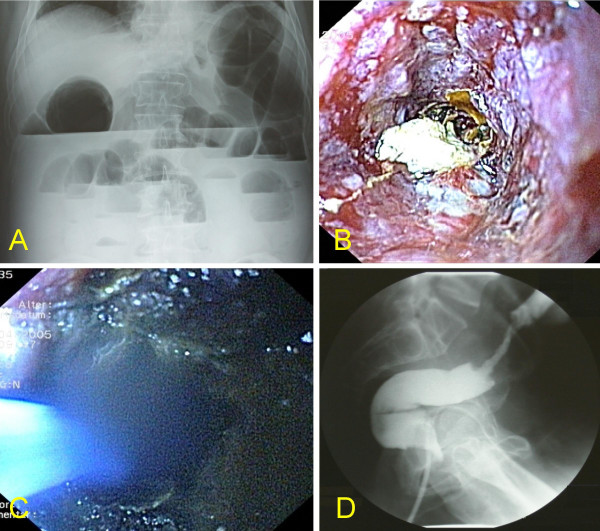
Abdominal X-ray of patient 2 at the time of first presentation showing complete colon obstruction and dilatation (A). Colonoscopic view of the sigmoid tumor with complete obstruction (B). Colonoscopic view during APC ablation of the tumor (C); X-ray enema two days after APC ablation showing the channel through the stenosis (D).